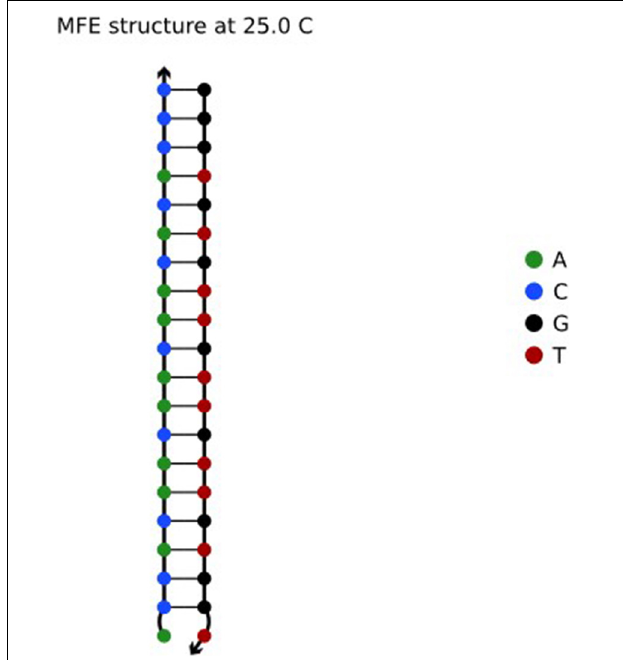
FIGURE 1 | Sequence ACCACAACAACAACACACCC and its complementary sequence.